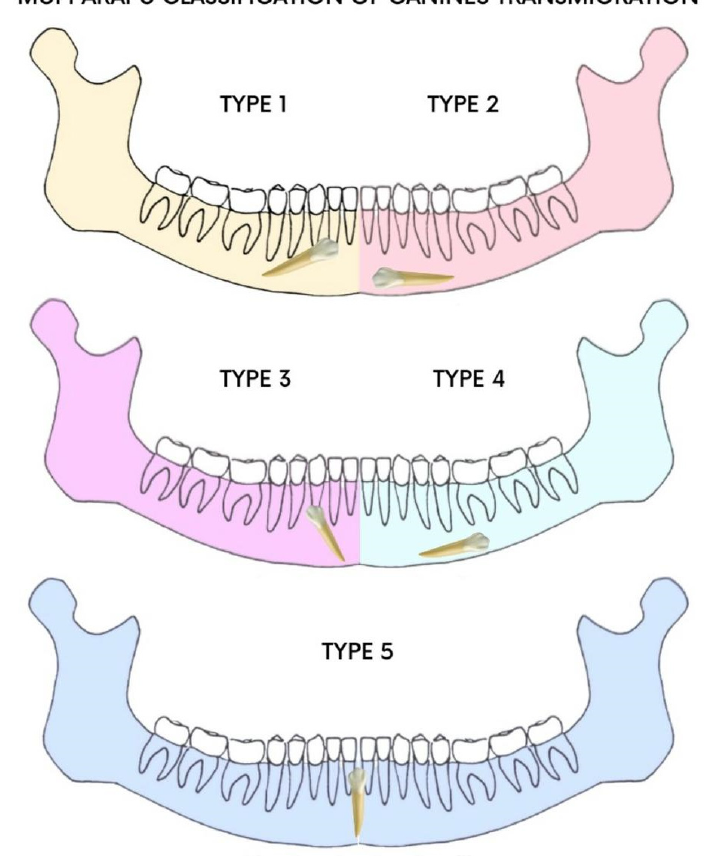
Figure 1. Mupparapu classification.